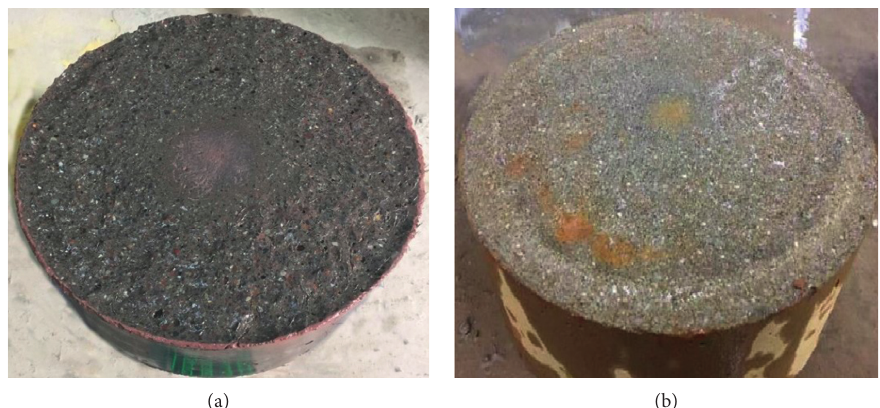
Figure 5: Steel fiber UHPC and rubber UHPC specimens after long impact abrasion for 168h: (a) steel fiber UHPC with 1.5% steel fiber; (b) rubber UHPC with 8 mesh rubber.